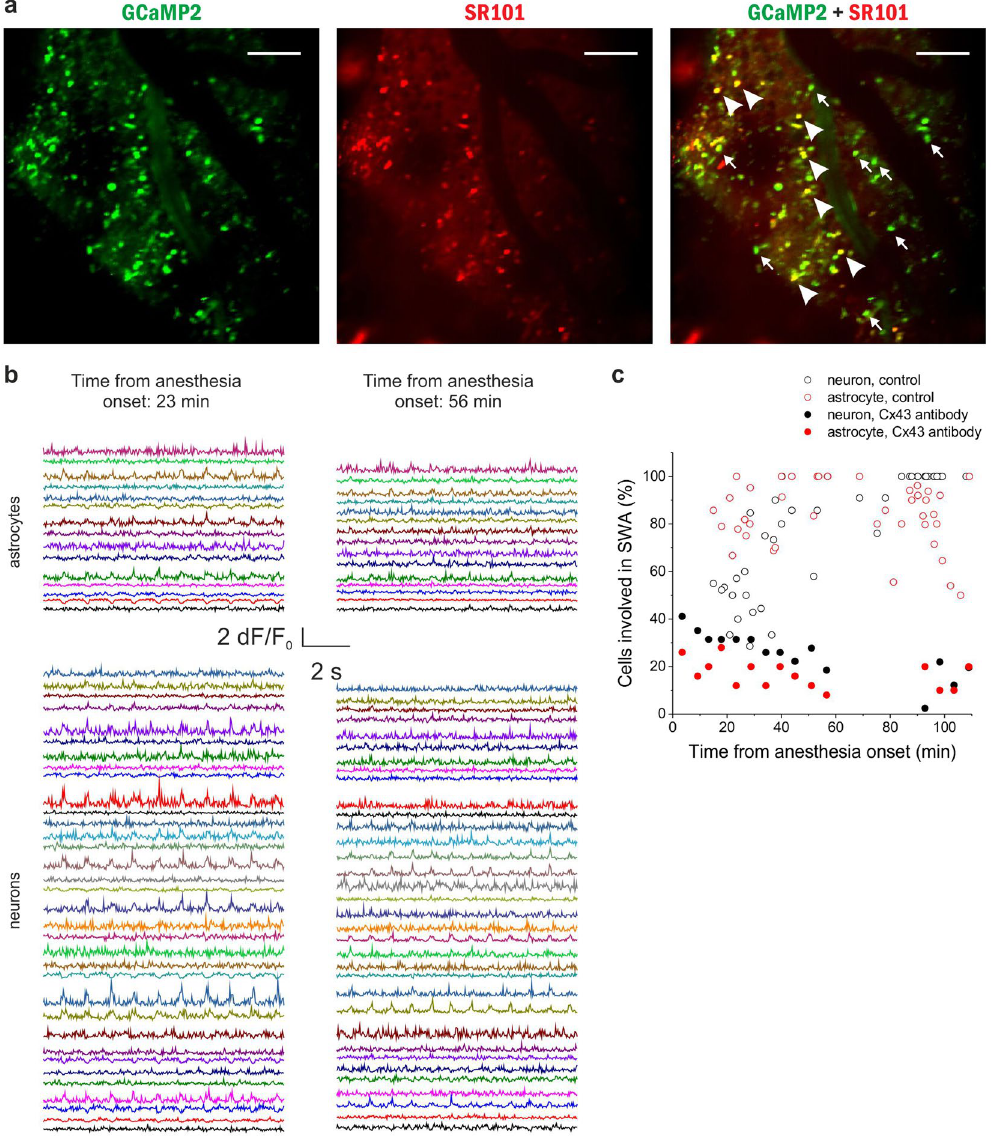
Figure 7. Specific blockade of the astrocytic gap junction subtype Cx43 inhibits synchronization in both astrocytes and neurons in vivo . ( A ) Expression of GCaMP2 (green), labeling of astrocytes with SR101 (red). Both neurons (some marked by arrows) and astrocytes (some marked by arrowheads) express GCaMP2. Scale bars: 100 µ m ( B ) Left: 10-sec segments of ∆ F/F 0 fluorescent intensity traces of all identified astrocytes (n = 15) and neurons (n = 34) in the imaged area at 23 min following anesthesia. Right: 10-sec segments of ∆ F/ F 0 fluorescent intensity traces of all identified astrocytes (n = 15) and neurons (n = 34) in the imaged area at 56 min following anesthesia. The same cells were imaged at 23 and 56 min. Cx43 antibody was applied 24 hours before the experiment. ( C ) The ratio of astrocytes (red) and neurons (black) showing repetitive, UP state-related Ca 2 + transients in percentage of all astrocytes or neurons, respectively, in the field of views in the same P43 rat in the presence of Cx43 antibody (solid markers).Individual markers represent data from each 300-sec imaging sessions. Empty markers represent the ratio of astrocytes (red) and neurons (black) showing repetitive, UP state-related Ca 2 + transients in the absence of Cx43 antibody. Note that large-scale synchronization is inhibited by the Cx43 antibody in both neurons and astrocytes. All data were recorded from the V1 area of a P43 rat (n = 15 imaging session, 300 s